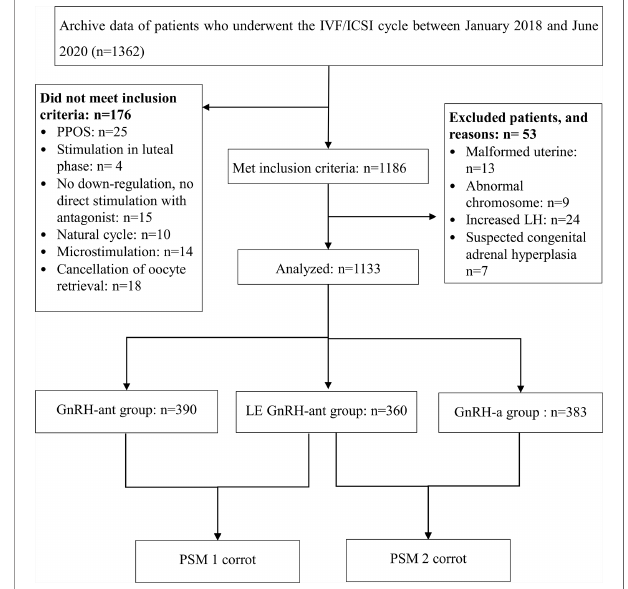
FIGURE 1 | Patient recruitment fl owchart. IVF/ICSI: in vitro fertilisation or intracytoplasmic sperm injection; GnRH-a: gonadotropin-releasing hormone-agonist; GnRH-ant: gonadotropin-releasing hormone-antagonist; LE: